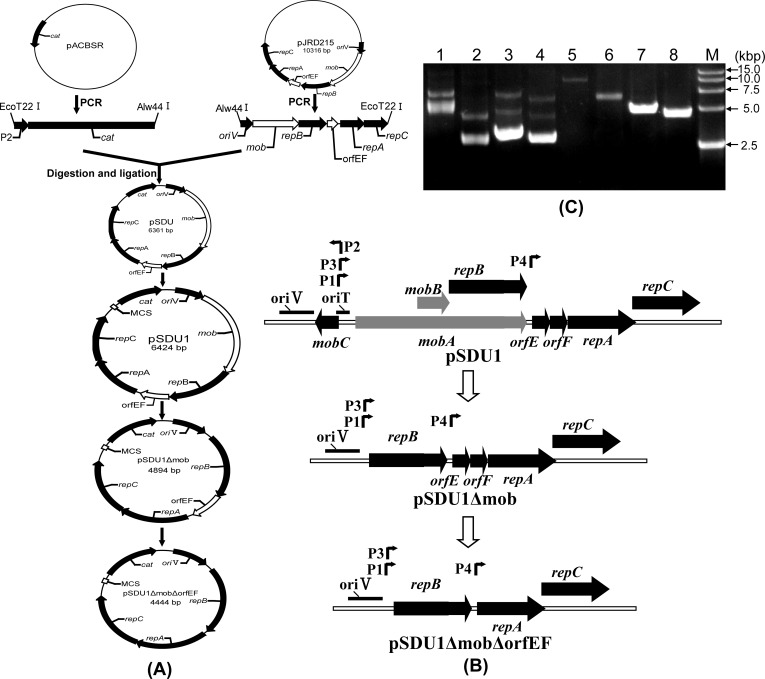
Construction of pJRD215-derived plasmids.(A) Construction processes of pSDU1, pSDU1Δmob, and pSDU1ΔmobΔorfEF. A P2-cat cassette was constructed by the fusion of the promoter P2 from the plasmid pBR322 and the cat gene from plasmid pACBSR. The generated cassette and the backbone amplified from plasmid pJRD215 were ligated to generate plasmid pSDU. After that, the multiple cloning sites originated from pUC19 were introduced into pSDU to construct the plasmid pSDU1. To construct pSDU1Δmob, the mobB gene and a part of mobA gene on pSDU1 was removed. Finally, the orfEF region was further deleted from pSDU1Δmob, resulting in plasmid pSDU1ΔmobΔorfEF. (B) The detail diagram of the new pJRD215-derived plasmids. (C) Electrophoretic analysis of plasmids. Lane 1, 5: pJRD215; lane 2, 6: pSDU1; lane 3, 7: pSDU1Δmob; lane 4, 8: pSDU1ΔmobΔorfEF; lane 5–8, plasmids digested with Hind Ⅲ.